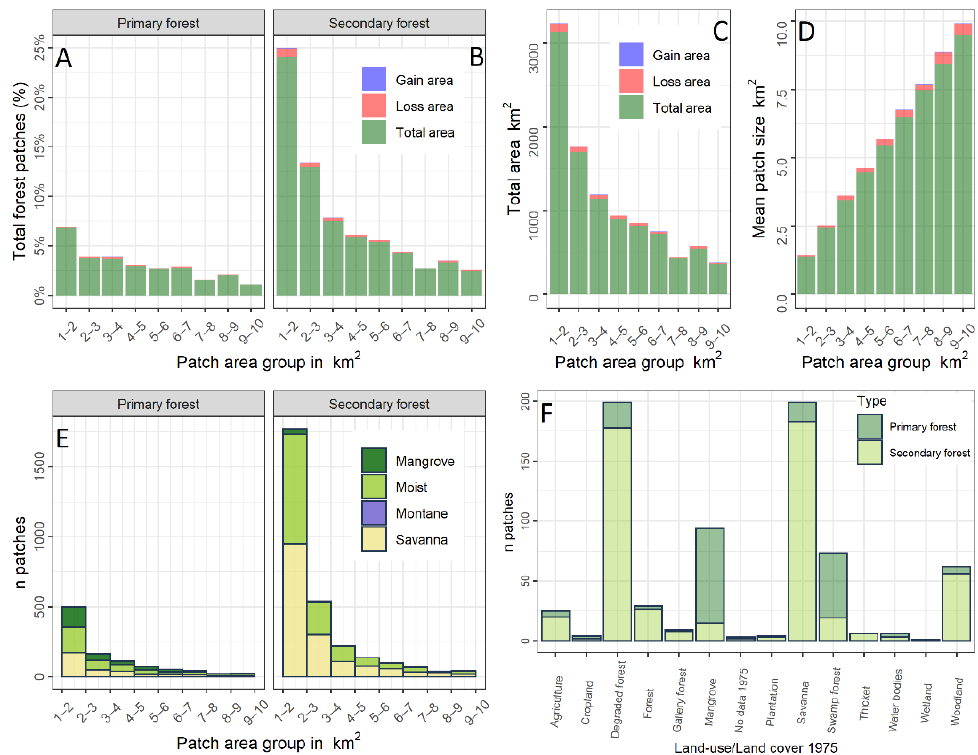
Figure 5. ( A ) Bar graph showing the area of forest patches as a percentage of total number of patches per size class (area/sum [area]) (km 2 ) and whether comprising primary or ( B ) secondary forest; percentage change (loss and gain) is also shown. ( C ) The total area, area of loss, and area of gain, in each size class are graphed, revealing that most patches are small and cumulatively have lost the most area. ( D ) The average area of the forest patches per size class, and the average area of the loss and gain per size class; on average, large patches experience greater areal loss. ( E ) Frequency distribution histogram showing the number of patches across four different biomes, and whether they comprise primary or secondary forest. ( F ) Bar plots show the number of forest patches, their land-use/land cover in 1975, and whether they comprise primary or secondary forest.